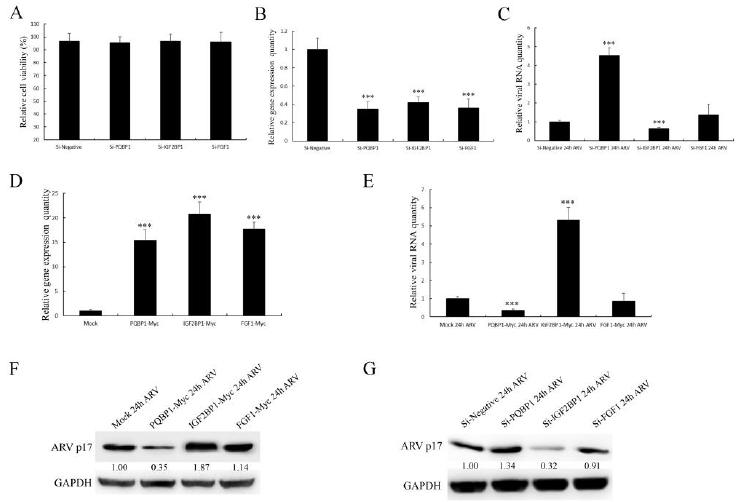
Figure 6. Detection of the mRNA expression of the identified protein interacting with ARV p17 after ARV infection for 12 h by qRT-PCR. Data were pooled across experiments and analyzed using t tests. Bars indicate the grand means ± standard deviation (SD). ***, p < 0.001.